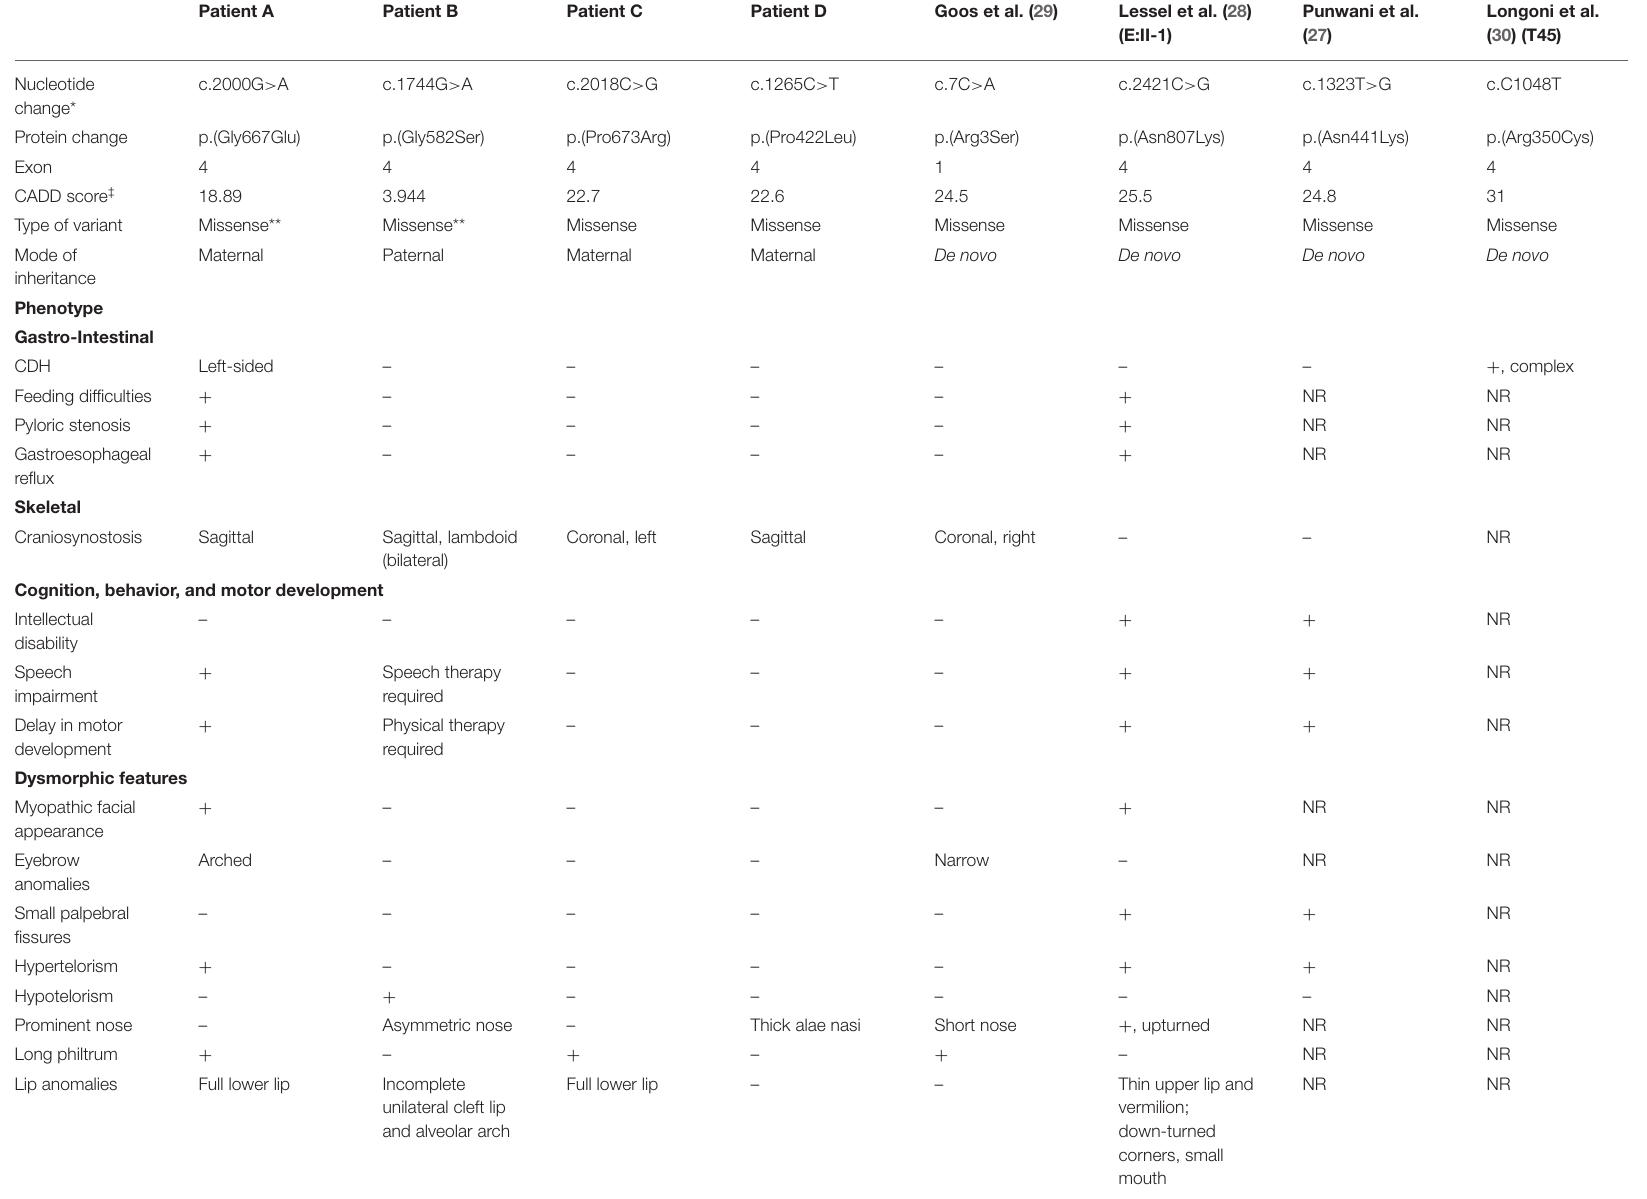
TABLE 1 | Case descriptions of patients with BCL11B missense variants: genetic and phenotypical